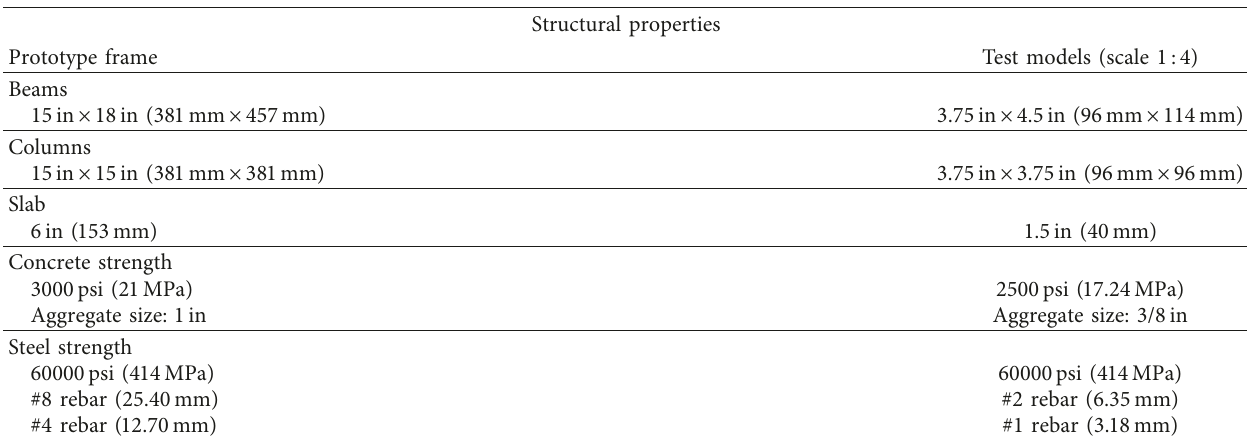
Table 2: Properties of test models.